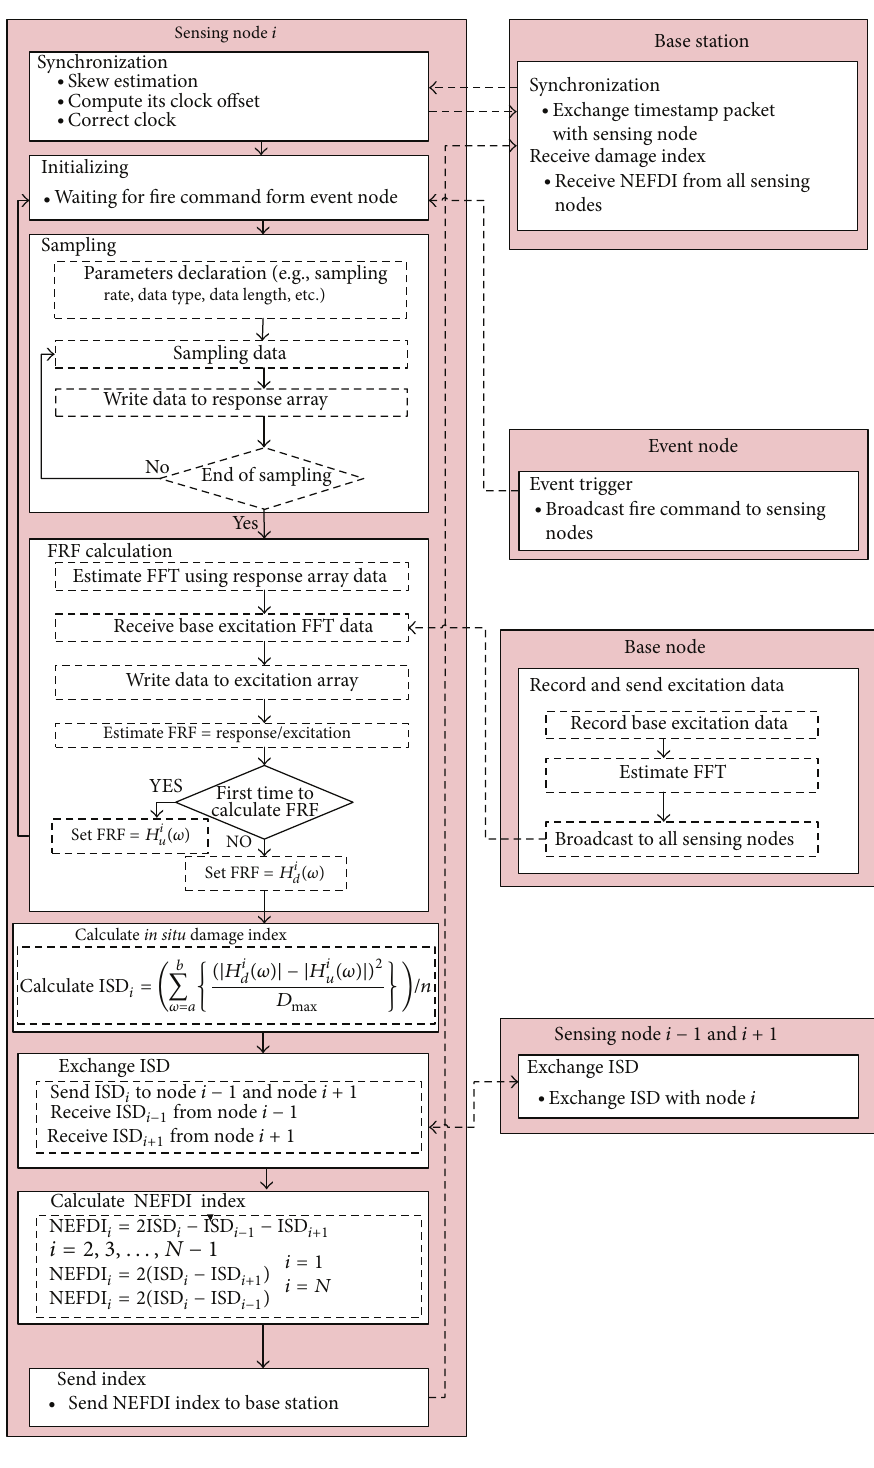
Figure 7: NEFDI-based protocol in the Imote2.NET SHM